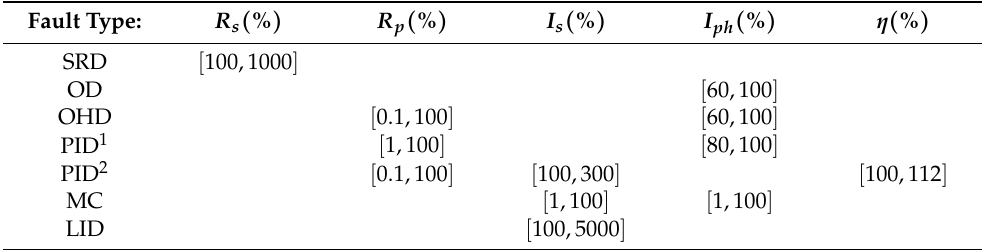
Table 1. Parameter variations for different fault